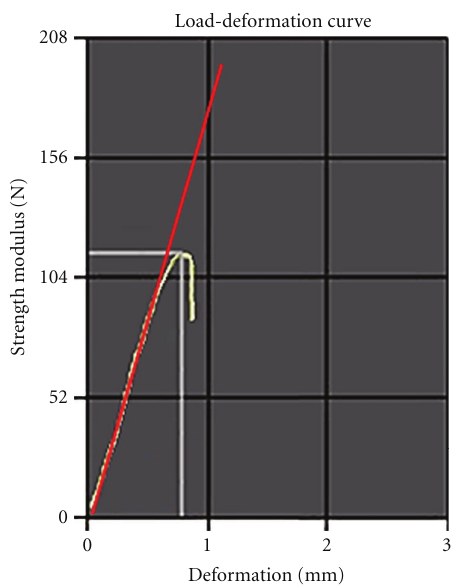
Figure 4: Load-deformation